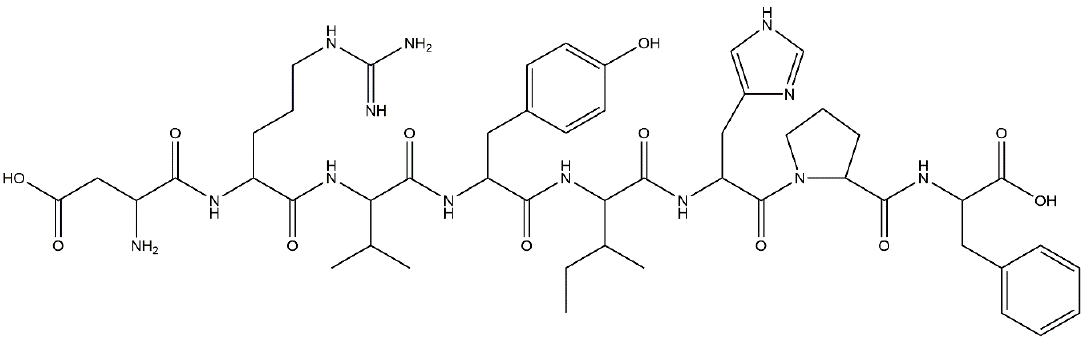
Figure 6. The chemical structure of angiotensin II.